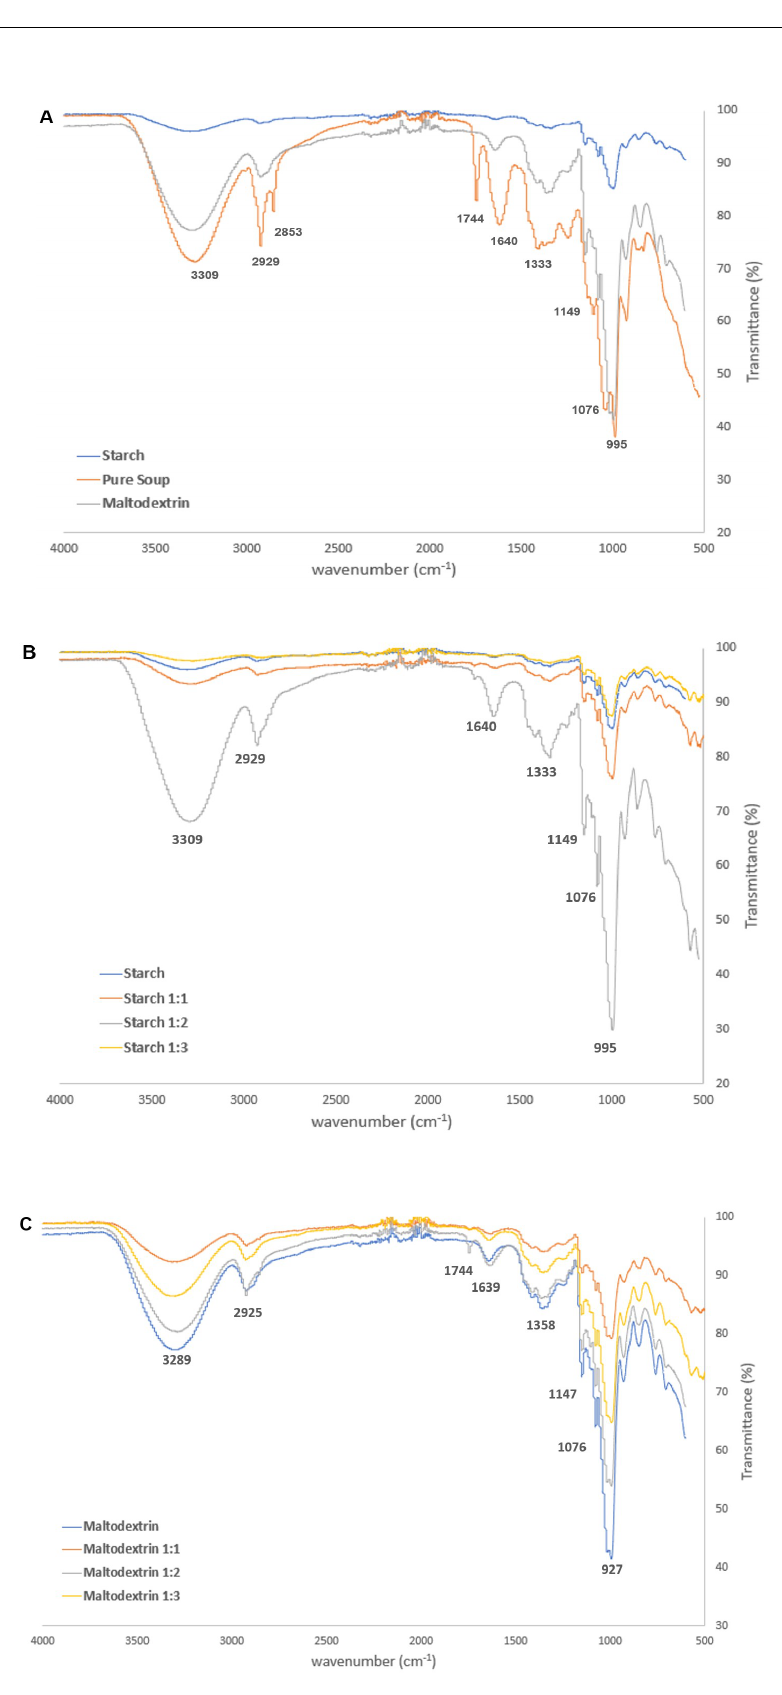
Figure 2. Infrared absorption spectra (FTIR) of lyophilized (powdered) beetroot soups: ( A ) beetroot soup microencapsulated in starch at 1:1, 1:2 and 1:3 ratios, ( B ) beetroot soup microencapsulated in maltodextrin at 1:1, 1:2 and 1:3 ratios and ( C ) pure beetroot